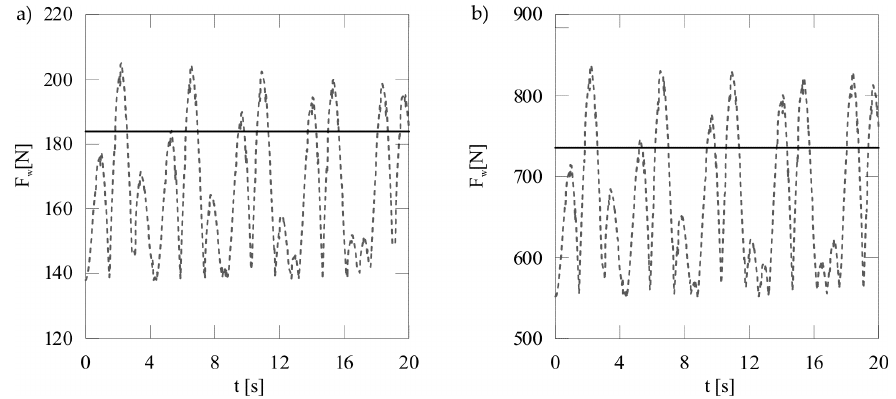
Figure 7. Value of the wind impact force with respect to wind velocity equal to ( a ) 10 m/s and ( b ) 20 m/s (continuous line—fixed area, dotted line—variable area).